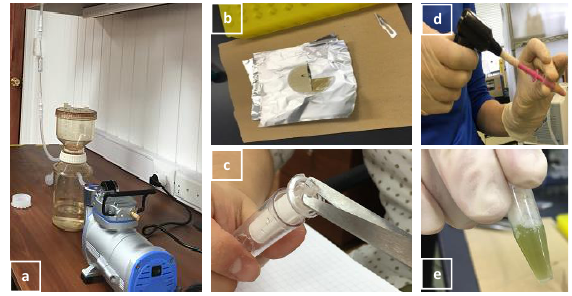
Figure 4. DNA extraction procedure: ( a ) filtration set up, ( b ) filtered one µ m pore-sized membrane cut in half, ( c ) filtered 0.2 µ m pore-sized Sterivex membrane, ( d ) homogenizing membrane in a tube with a Pellet Pestle ™ Cordless Motor, and ( e ) DNA extraction product by 5% Chelex method.